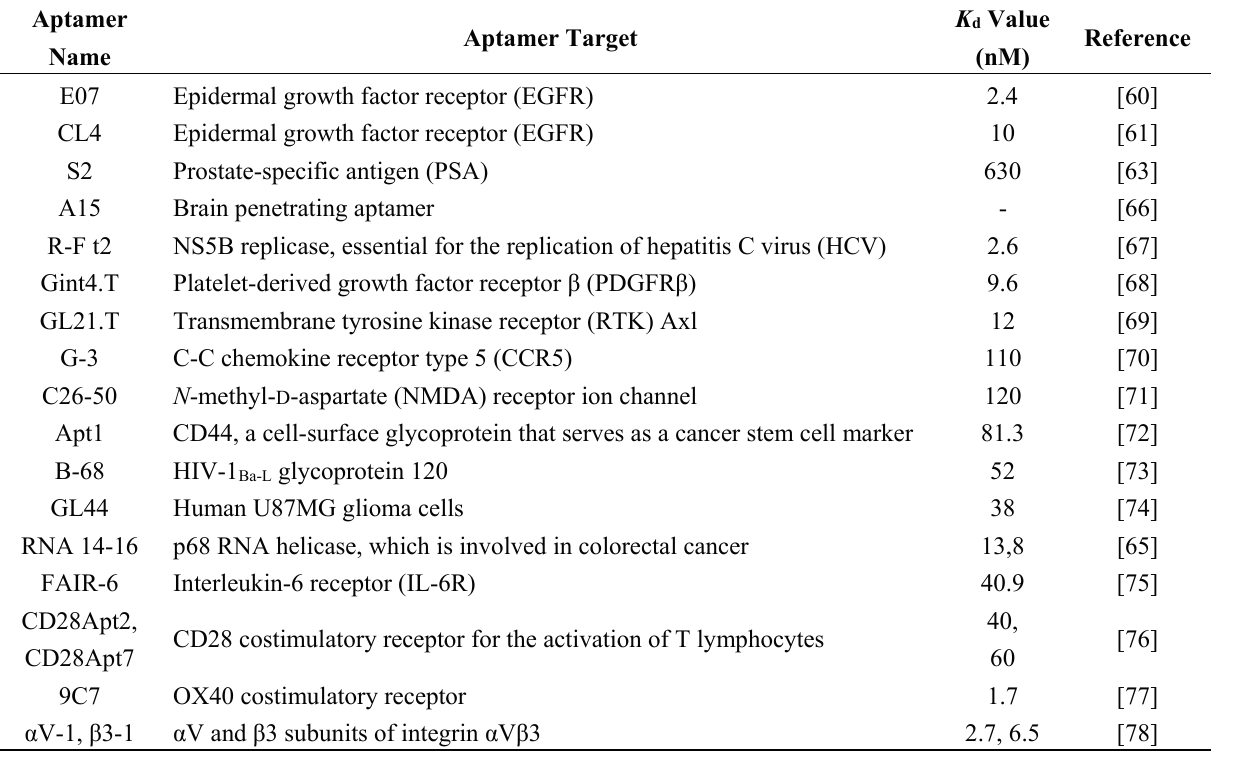
Table 1. Summary of the recently generated aptamers using the 2 ′ -fluoro modification.